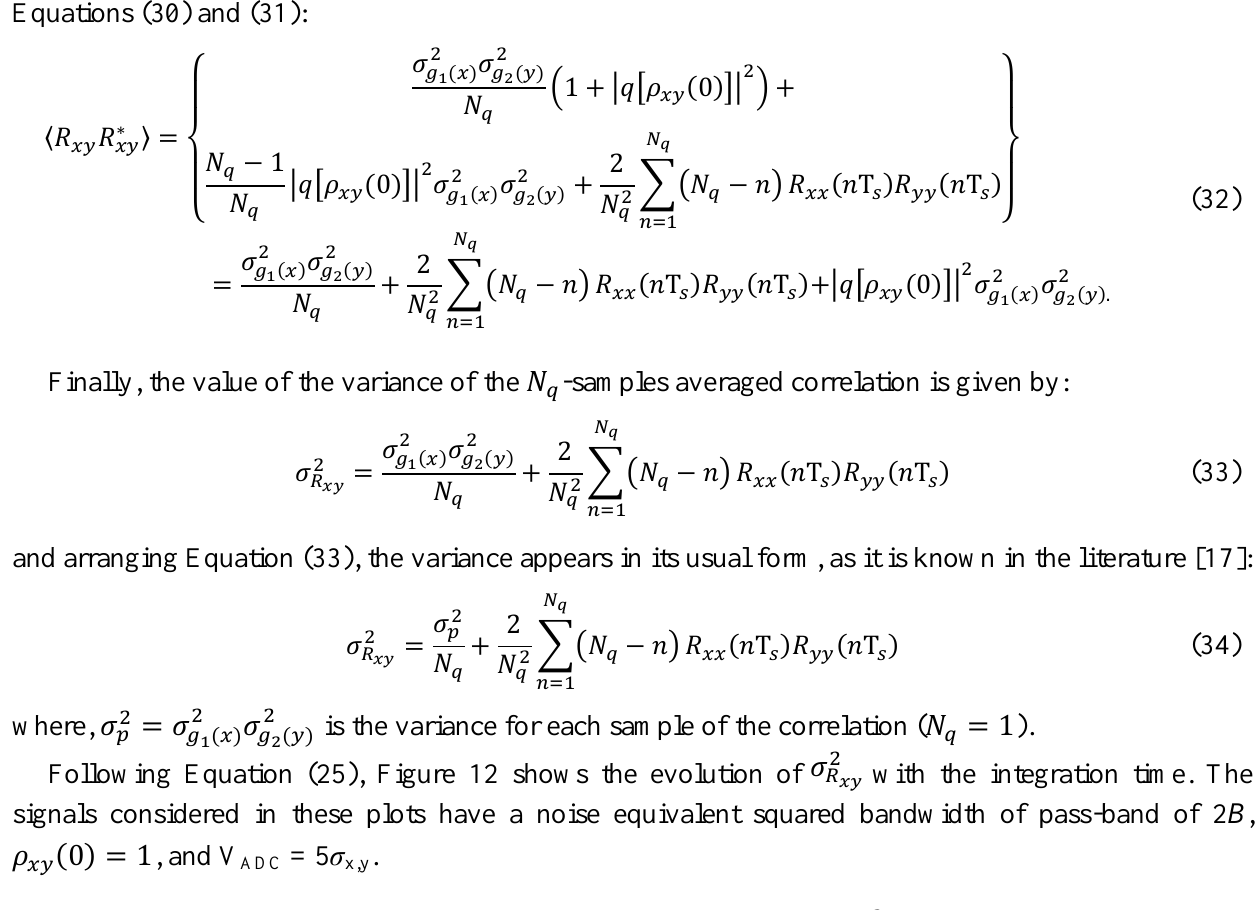
Figure 12. Impact of the number of averaged samples on the , (a) shows the impact for a 3 level quantization scheme and different sampling rate, and (b) shows a constant sampling rate changing the number of quantization